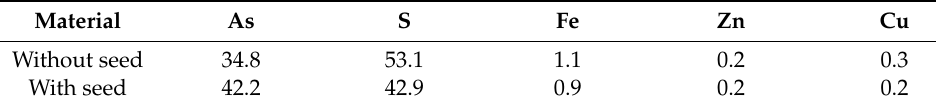
Figure 9. Micrographs of precipitates obtained without seed crystal introduction at NaHS/As = 2.80 ( a ) and with the introduction of As 2 S 3 34 g/L seed crystal at NaHS/As = 2.25 ( b ). Table 3. Chemical composition of arsenic trisulphide,